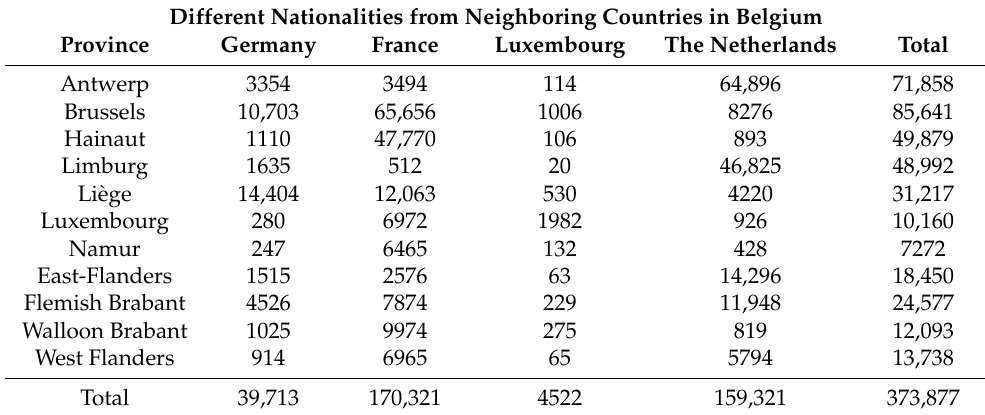
while the municipalities with the highest proportion of French nationals are in Brussels and close to Lille. Table 3. Number of people living in Belgium with a nationality from a neighboring country. Different Nationalities from Neighboring Countries in